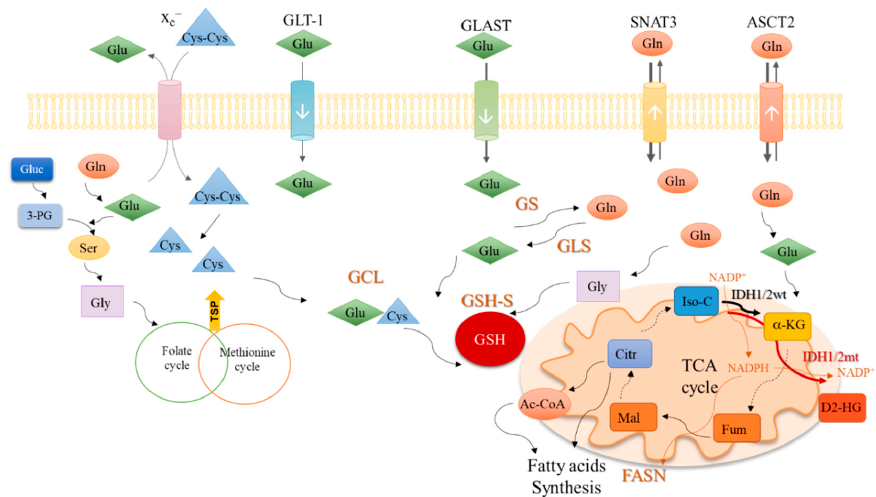
Figure 2. An integrative view of glutamine metabolism. Glutamine (Gln) is a core nutrient in cell metabolism. Gln can be synthesized within the cancer cell, by glutamine synthase (GS) or be taken up from the tumor microenvironment, though different transporters, as SNAT3 and ASCT2. Gln is catalyzed by glutaminases (GLS) enzymes and glutamate (Glu) is generated. Glu can be uptaken from the tumor microenvironment in a process mediated by transporters such as GLT-1 and GLAST. Glu controls the entrance of cystine (Cys-Cys) in the cell, mediated by x c– antiporter; Cys-Cys is then converted into cysteine (Cys). Gln-derived Glu is used as a nitrogen source in the synthesis of serine (Ser) from glucose (Gluc)-derived 3-phosphoglycerate (3-PG). Serine (Ser) can be converted into glycine (Gly) that supplies one-carbon metabolism (folate cycle plus methionine cycle) from which cysteine (Cys) is synthesized through the transsulfuration pathway (TSP). Glu, Cys and Gly are the three components of glutathione (GSH), whose synthesis occurs in two steps. In the first step, Glu and Cys are linked by glutamyl-cysteine ligase (GCL) and afterward, Gly is added to the dipeptide Glu-Cys by glutathione synthase (GSH-S). Gln-derived Glu can be converted into α -ketoglutarate ( α -KG) and enter the tricarboxylic acids (TCA) cycle. α -KG can also be synthesized by isocitrate dehydrogenase 1/2 wild type (IDH1/2wt) enzymes from isocitrate (Iso-C), with the consumption of NADP + and release of NADPH. NADPH is canalized to other metabolic pathways such as the fatty acid synthesis catalyzed by the fatty acids synthase (FASN). The isocitrate dehydrogenase 1/2 mutant (IDH1/2mt) enzymes further catalyze the conversion of α -KG into the onco-metabolite, 2-hydroxyglutarate (D2-HG), with NADPH consumption. Different Gln-derived TCA cycle intermediates such as fumarate (Fum), malate (Mal), citrate (Citr), and acetyl-CoA (Ac-CoA) can be deviated to supply fatty acid synthesis.